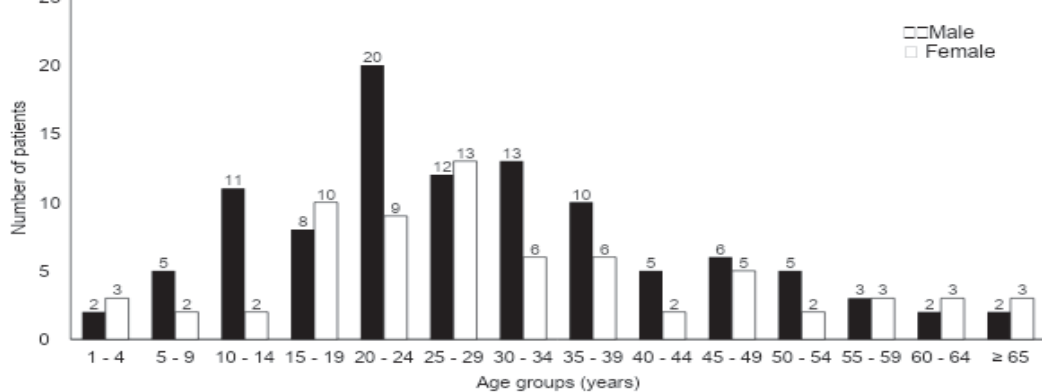
Figure 1. The age and sex distribution of patients treated for acute